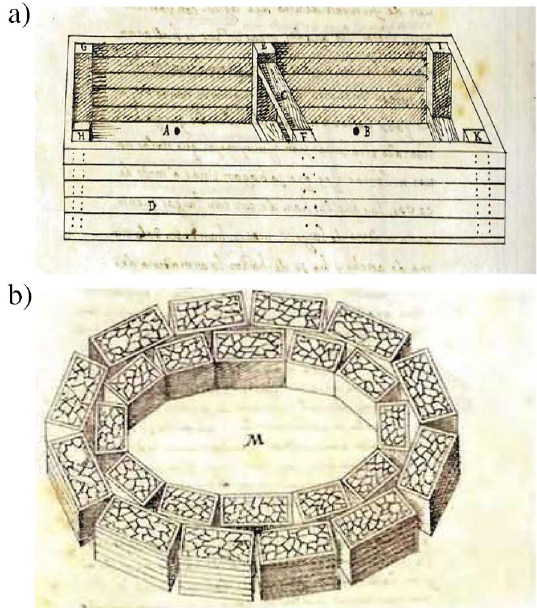
Fig. 14 a Enclosure of sheet piles to be founded in the water,